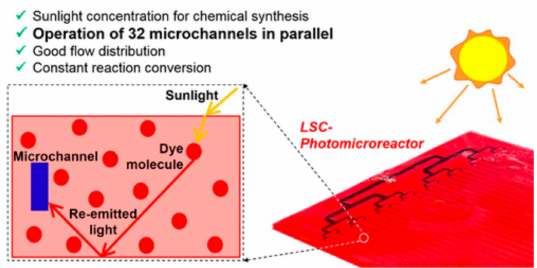
Figure 7. Exploiting solar light for scaled luminescent solar concentrators (LSC) applications (reproduced with permission from